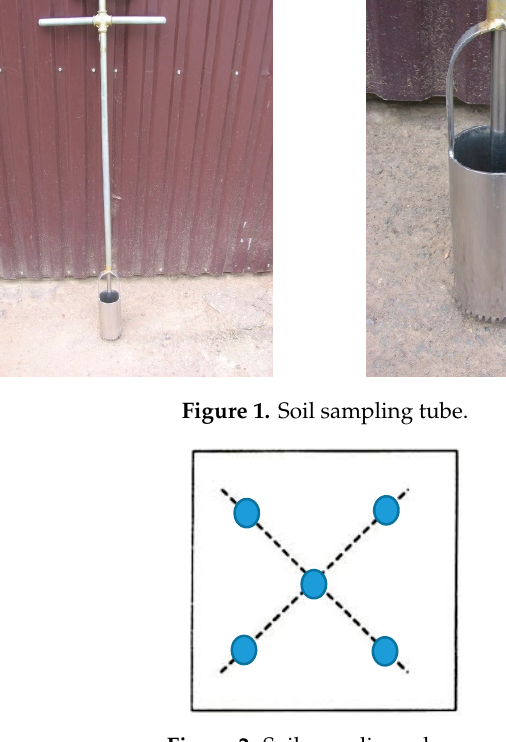
Figure 2. Soil sampling scheme.